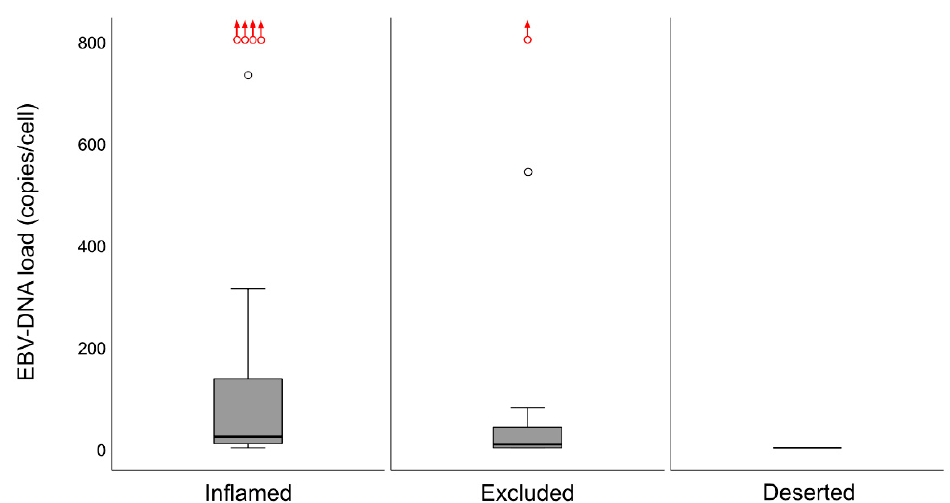
Figure 8. Differences in intralesional EBV DNA load (copies / cell) for immune phenotypes are shown (medians and IQR with whiskers denoting 1.5 IQR and outliers as circles). A marked difference in DNA load was present between the “inflamed” and “deserted” phenotypes ( p = 0.00034). The differences between “inflamed” and “excluded” and between “excluded” and “deserted” were not significant, though a trend was seen ( p = 0.055 and p = 0.079, respectively). Higher load outliers (range 1237 − 94617 copies/cell) are indicated with red circles and upwards-pointing red arrows. Abbreviation: EBV = Epstein–Barr virus.